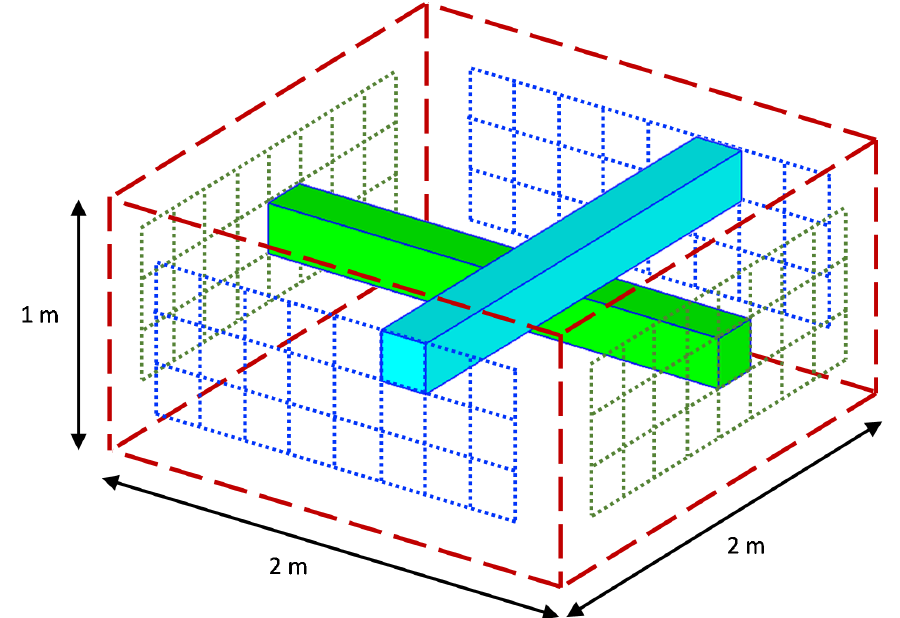
Figure 1. The entire volume of the simulated cloud chamber (2 × 2 × 1 m) is depicted with a dashed rectangular prism outline. Inside this volume, 48 high aspect ratio cuboids are extracted for optical analysis. Each cuboid, or cloud subsample, has dimensions of 0.2 × 0.2 × 2.0 m; 24 subsamples are taken from each horizontal direction in the chamber. Here, the dotted grids show the ends of the 48 cloud subsamples, with only a single 3D subsample (rectilinear parallelepiped) portrayed in each direction; the other 46 are hidden for the sake of clarity.